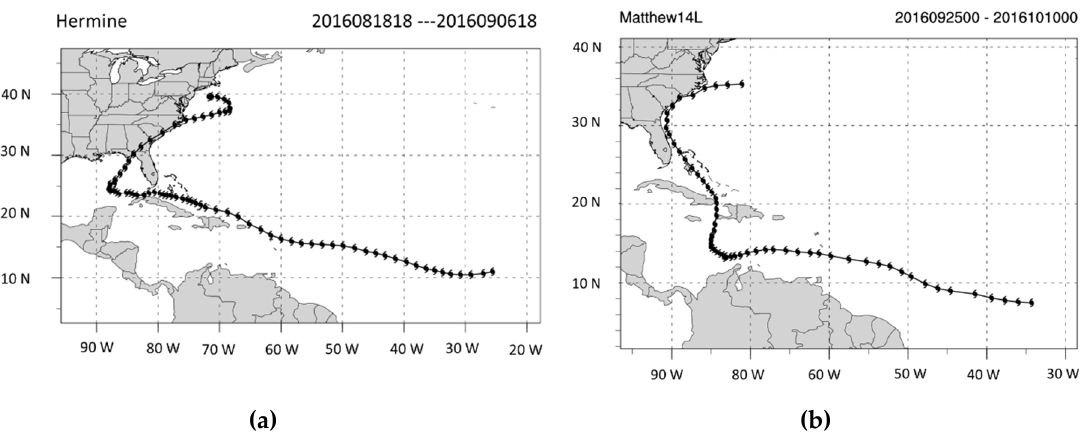
Figure 5. Observed hurricane tracks of Hermine ( a ) and Hurricane Matthew ( b ), 2016, storm center locations plotted every 6 h .